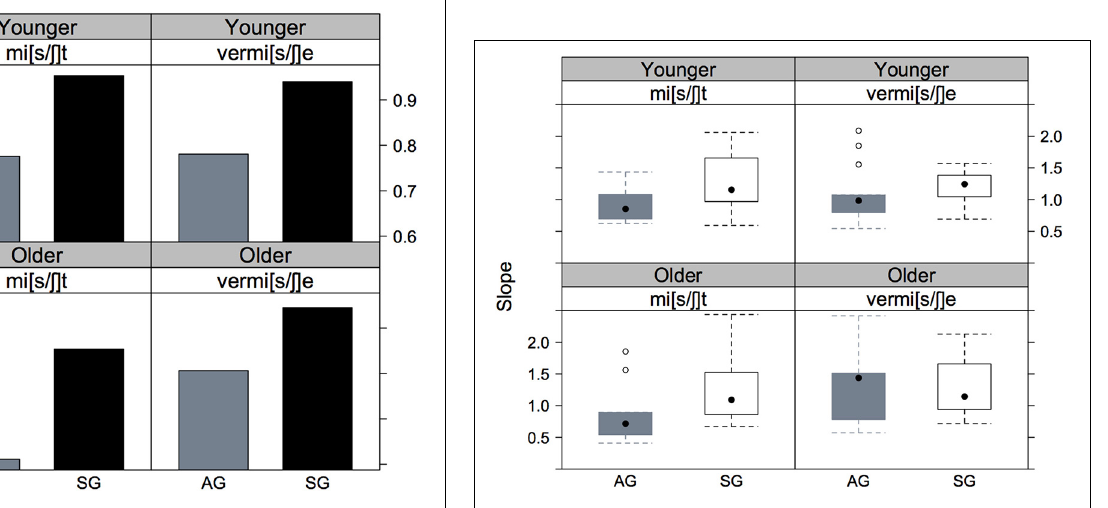
(cid:2) (cid:2) FIGURE 4 | The slopes of the psychometric curves shown in Figure 3 ]t (left column) and vermi[s/ ]e (right column) continua and for mi[s/ for younger (row 1) and older (row 2), AG (gray) and SG (black) listeners.